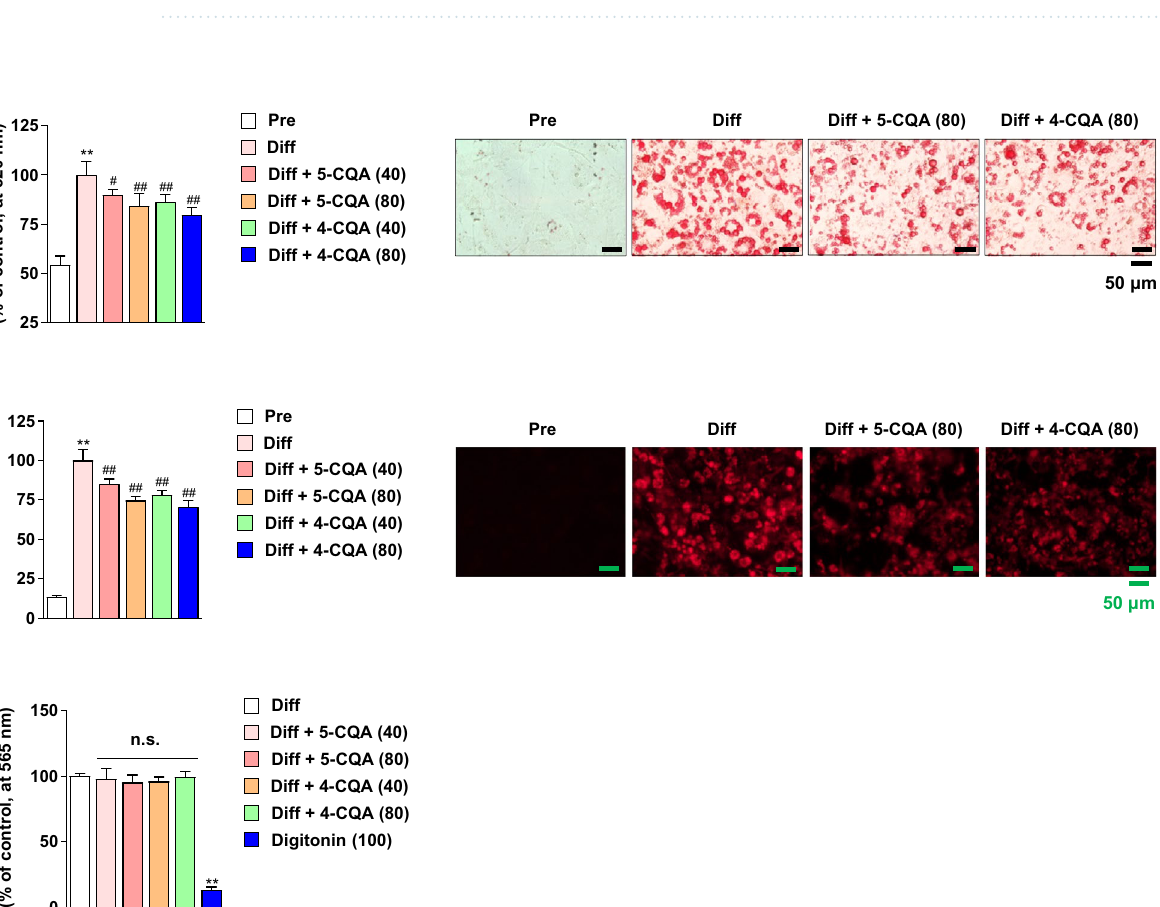
Table 1. Quantitative analysis of main compounds in MLE and BMLE (n = 6). a Data are represented as mean ± SD. RSD Relative standard deviation.